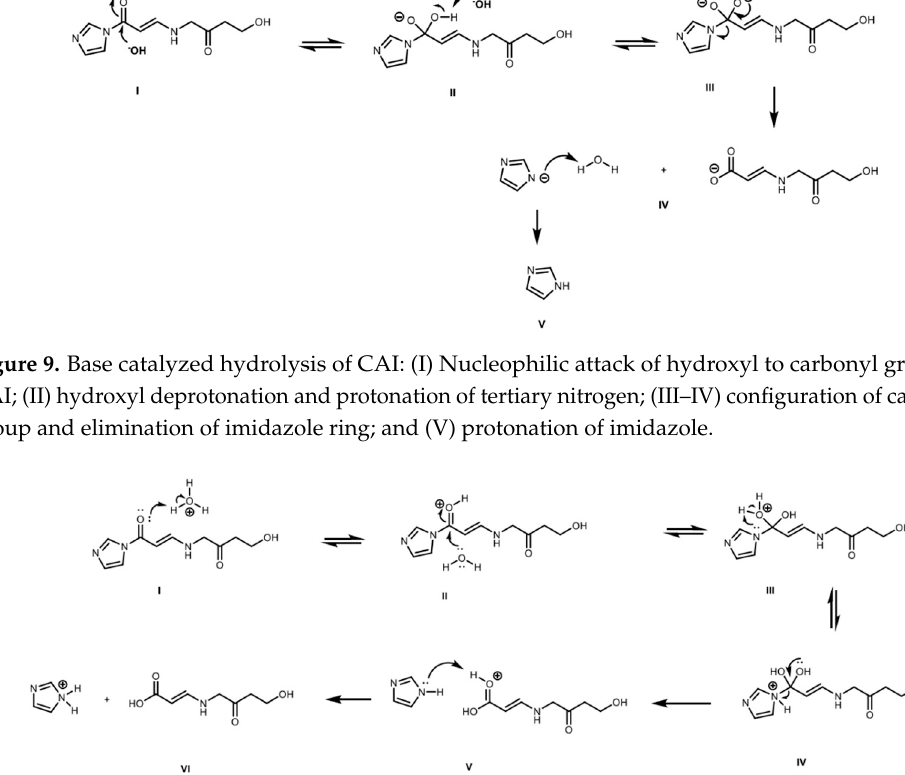
Figure 10. Acid catalyzed hydrolysis of CAI: (I) Protonation of carbonyl group of CAI; (II) Nucleophilic attack of water to carbonyl group of CAI; (III) water deprotonation; (IV) protonation of tertiary nitrogen and configuration or carboxyl group; (V) elimination of imidazole ring; and (VI) deprotonation of the carbonyl group and protonation of imidazole.